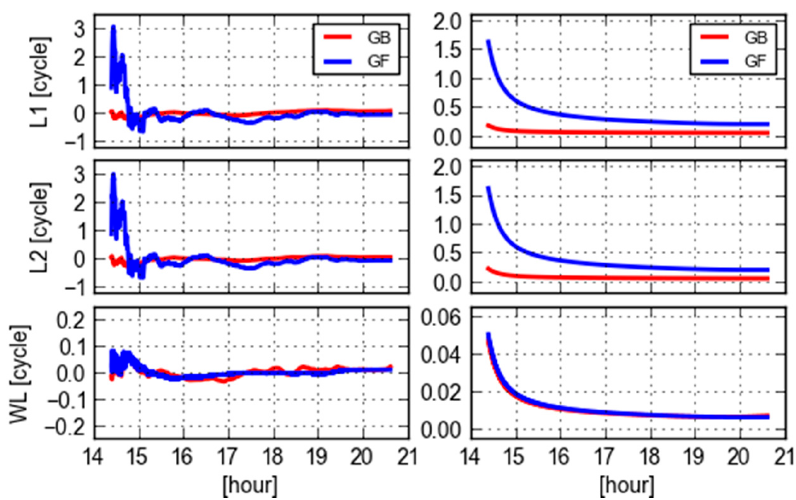
Figure 2. GF (blue) and GB (red) L1, L2 and WL ambiguities ( left ) and their corresponding formal errors ( right ) of PRN 09 computed from a single receiver (CEBR) observations and ESA final orbit and clock products.